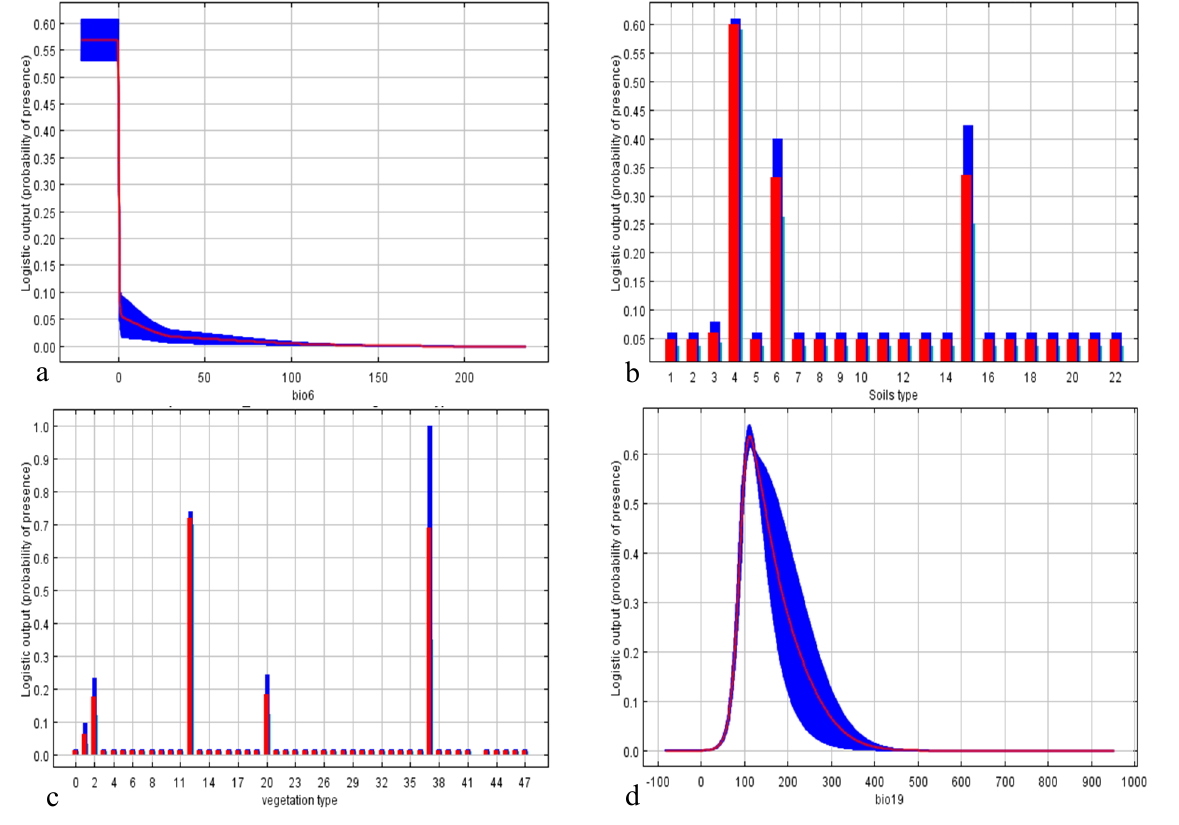
Figure 2. Response curves of the variables that most contributed to explain the potential distribution of Picea chihuahuana Martínez in Mexico ( a = minimum temperature of the coldest month (Bio6), b = soils type, c = vegetation type, d = precipitation of the driest month (Bio19)): model at national scale.